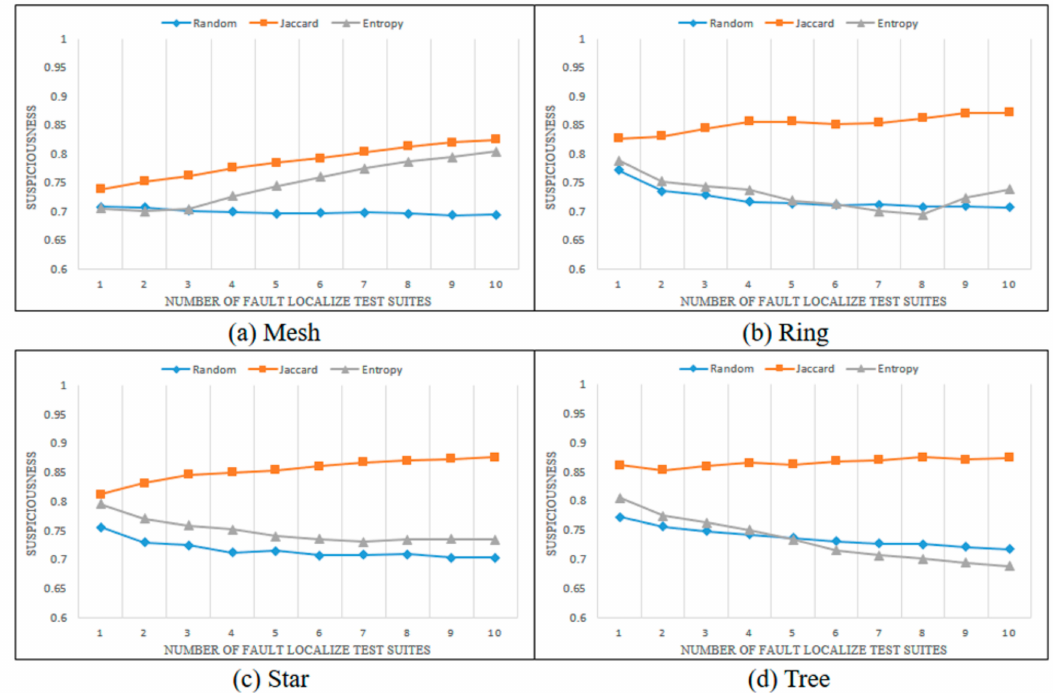
Figure 9. Average suspiciousness of faulty statements (hard-to-kill case).